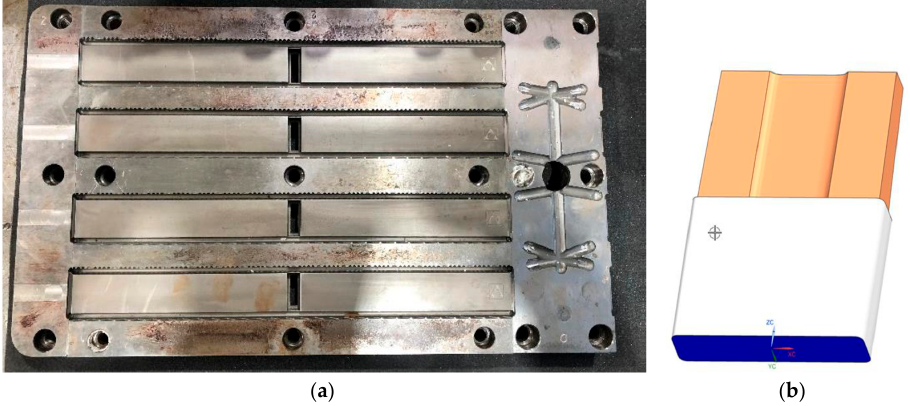
Figure 3. Mould disposition and key moulding elements. ( a ) Left and central sections of the ribs mould. From the depicted geometry, a total of four ribs can be extracted after a single injection operation. In each central vertical slot, one cooling insert should be placed prior to the injection. ( b ) Original cooling insert design (without cooling channels).